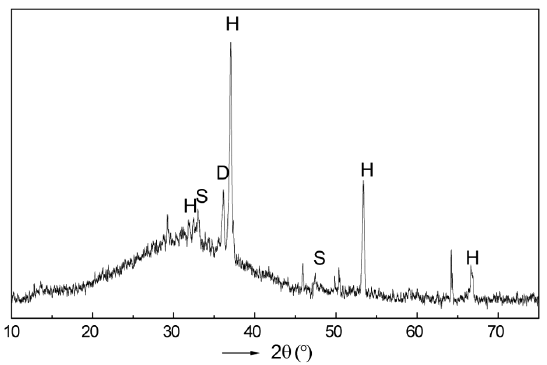
Fig. 1. The X-Ray diffraction pattern of CD: S –